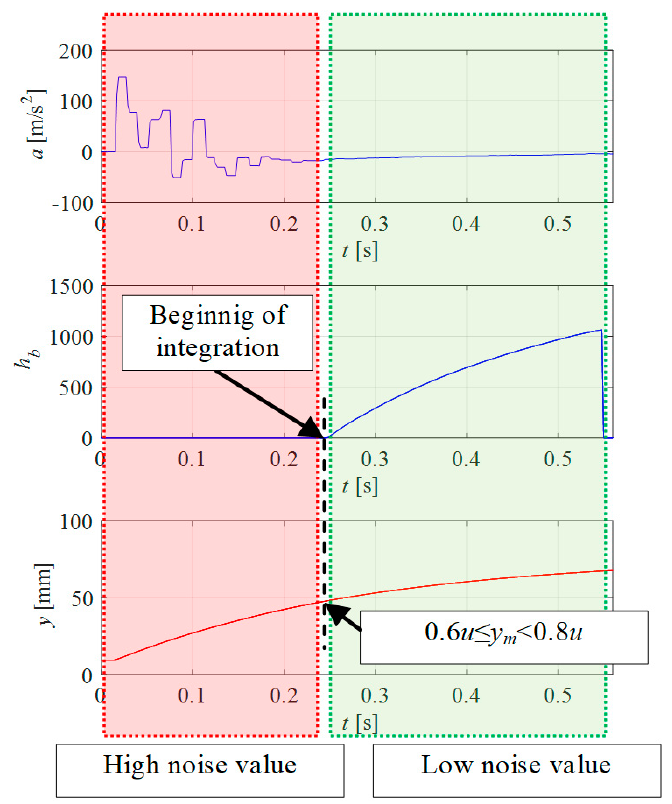
Figure 1. Waveforms of acceleration values and h b value during changing of the drive position. signal converted into an integer variable in the programmable logic controller (PLC). Tables 1 and 2 present the selected test results.